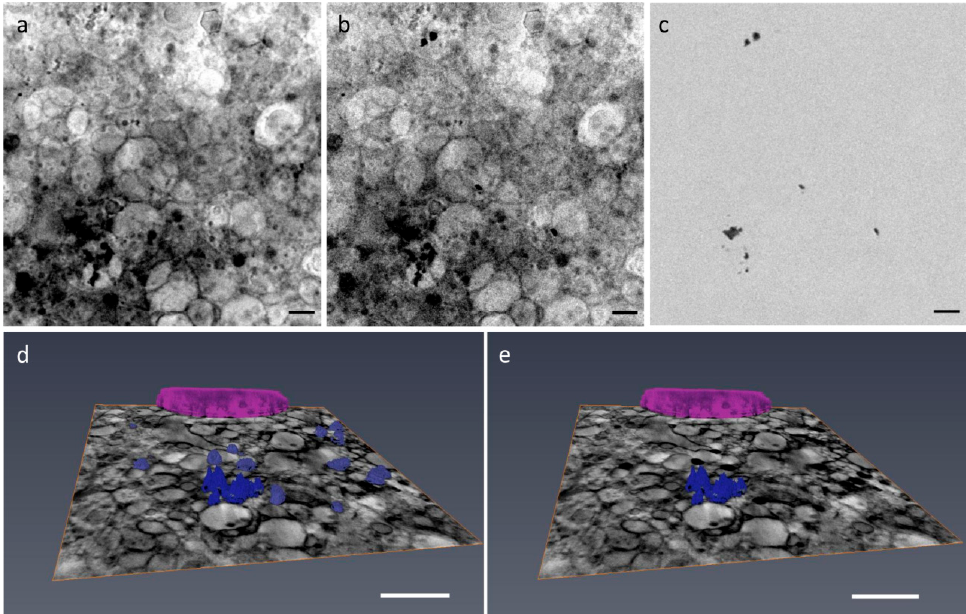
Figure 3. ( a , b ) Average of absorbance projections of a cytoplasm region in the cell showed in Figure 1 ( ≈ 10 μ m × 10 μ m) recorded at the pre Ca-edge energy region ( ≈ 342 eV) and at the Ca L 3 peak maxima ( ≈ 349 eV), where the contrast between Ca and the other elements is maximized. ( c ) Image difference between ( b ) and ( a ). Since the absorbance of all the other elements is almost the same in ( a , b ), their difference ( c ) reveals the Ca 2D distribution in the field of view. Scale bar is 1.3 μ m. ( d ) Color-coded 3D rendering of the nucleus and dense structures of another bMSC-4D. Dense structures voxels were selected automatically using a threshold. After spectral analysis, only some of these dense structures show Ca content. These Ca-rich voxels are reported in ( e ). Scale bar is 2 μ m.